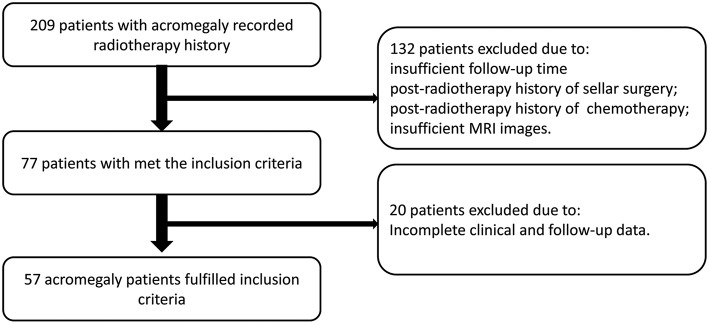
Patient recruitment pathway.